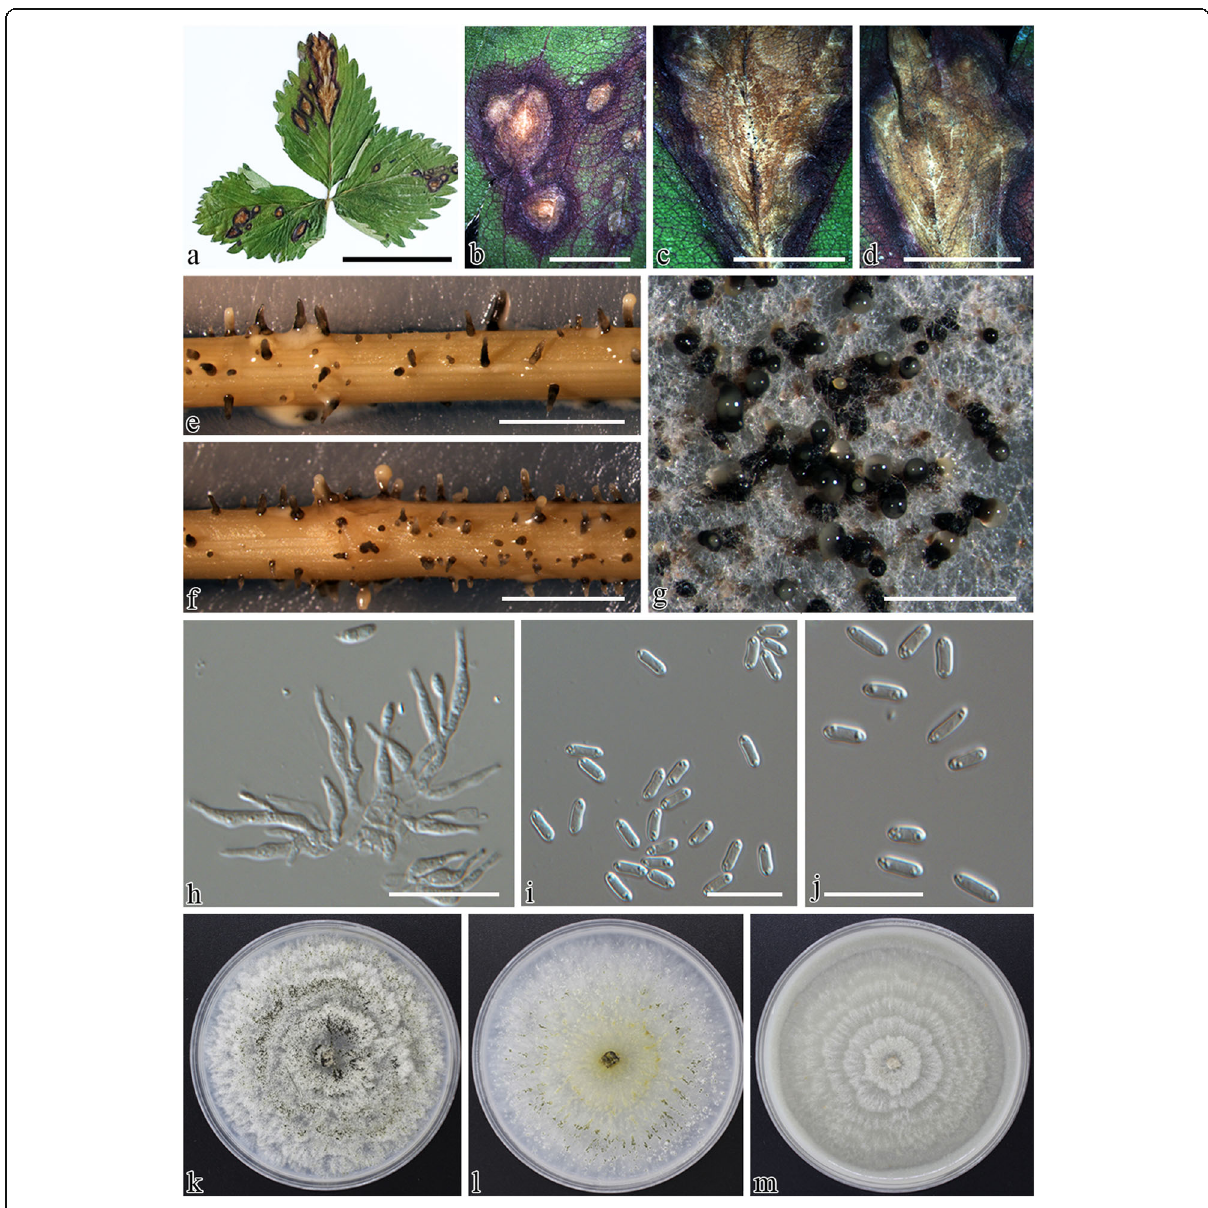
Fig. 2 Morphology of Paraphomopsis obscurans (BPI 919201, culture CBS 143829/M1262, isolate DS020). a Infected leaf of Fragaria × ananassa . b – d Leaf blight symptoms under stereo microscope. e,f Pycnidia on alfalfa stems on WA. g Pycnidia on PDA. h Conidiophores. i,j Conidia. k 7-d-old culture on PDA. l 7-d-old culture on MEA. m 7-d-old culture on V8A. Scale bars: a = 4 cm, b = 1.5 cm, c,d = 1 cm, e-g = 300 μ m, h-j = 10 μ